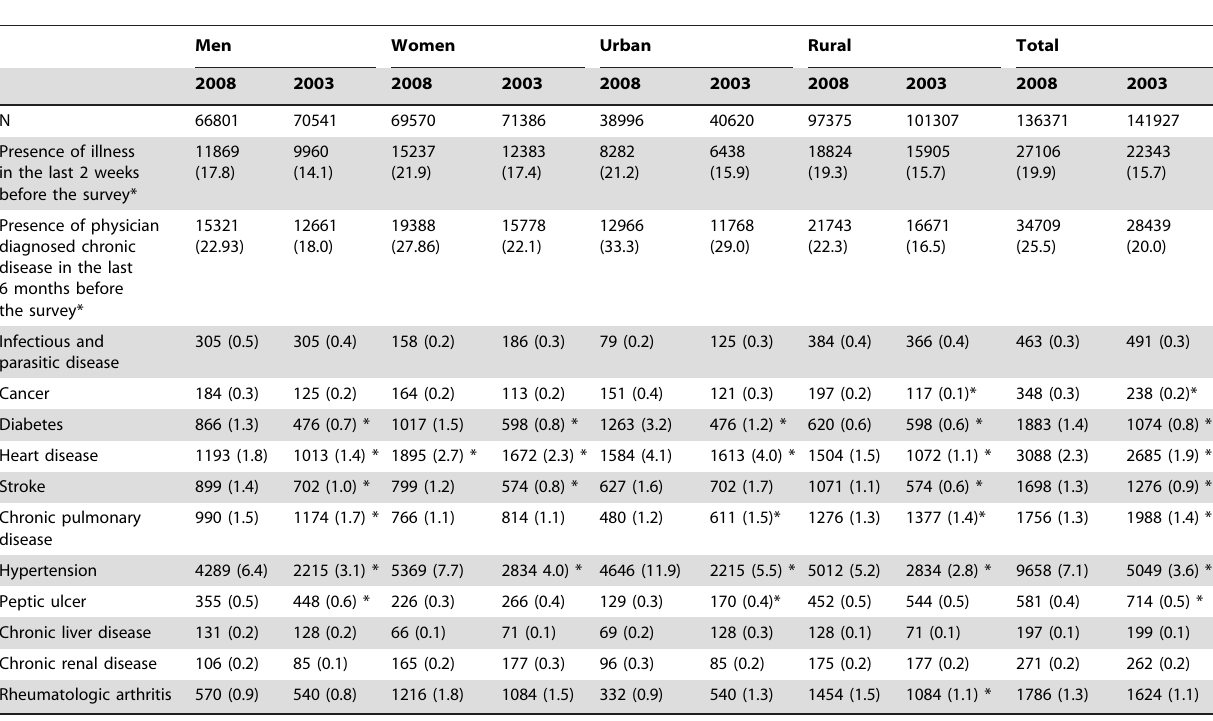
Table 2. Illness and morbidity in respondents aged . 18 years in China, 2003 and 2008.